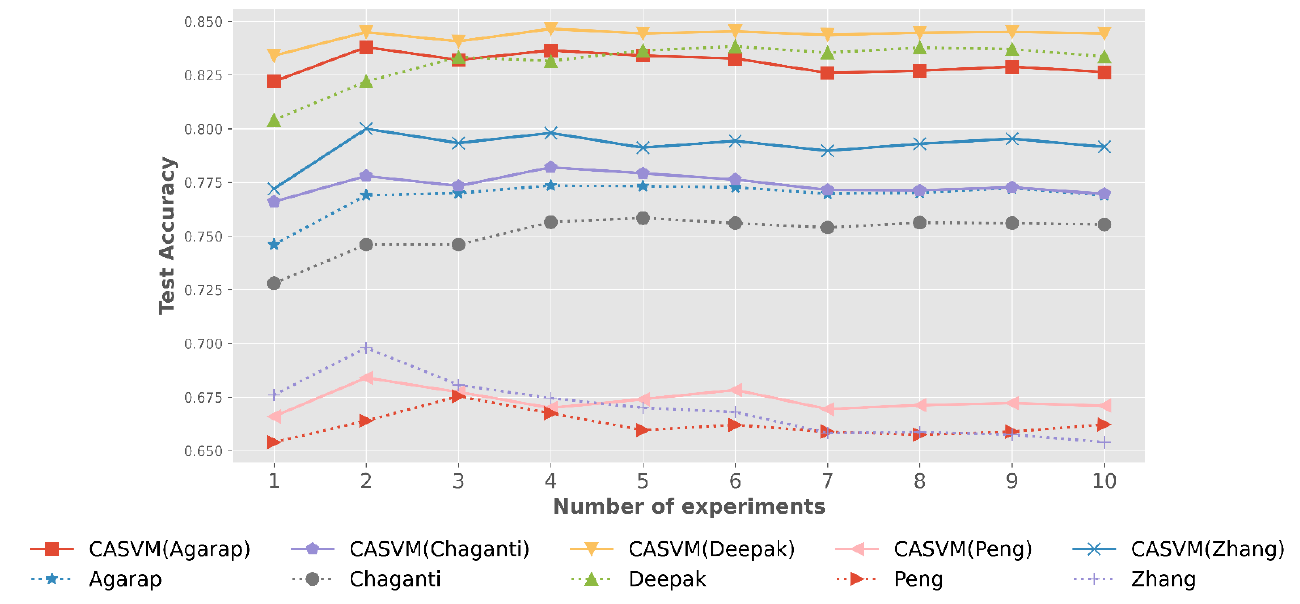
Figure 8. Test accuracy of different models.